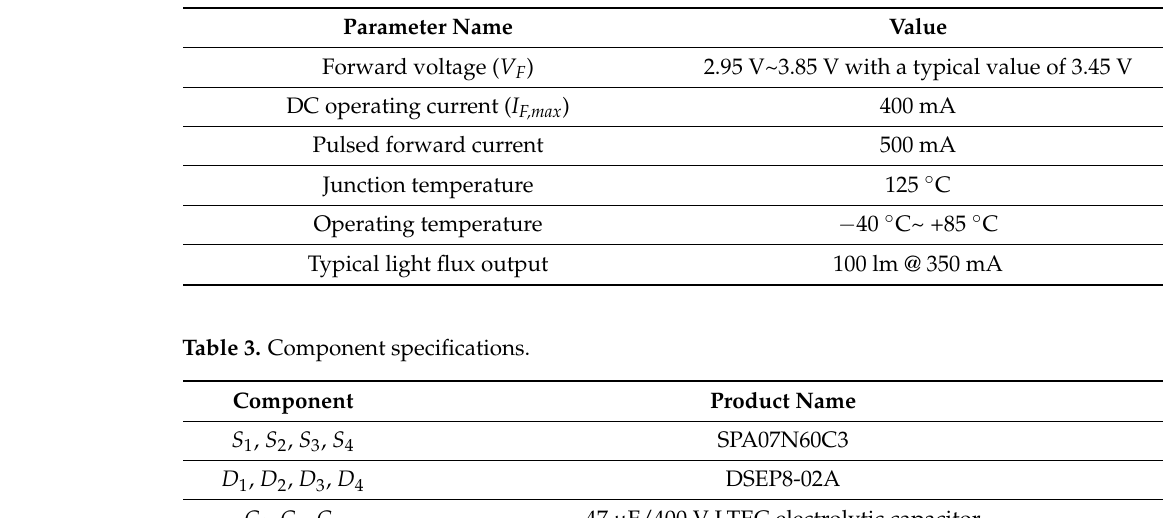
Table 2. LED specifications.